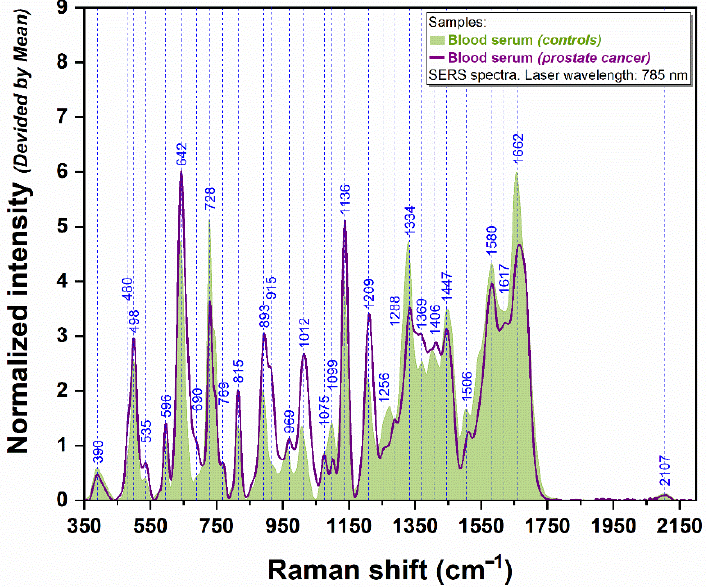
Figure 2. The average serum SERS spectra of PCa patients ( n = 29, magenta spectrum) and healthy donors ( n = 14, green spectrum), using a 785 nm laser. Table 2. PCA-LDA results on plasma and serum samples.